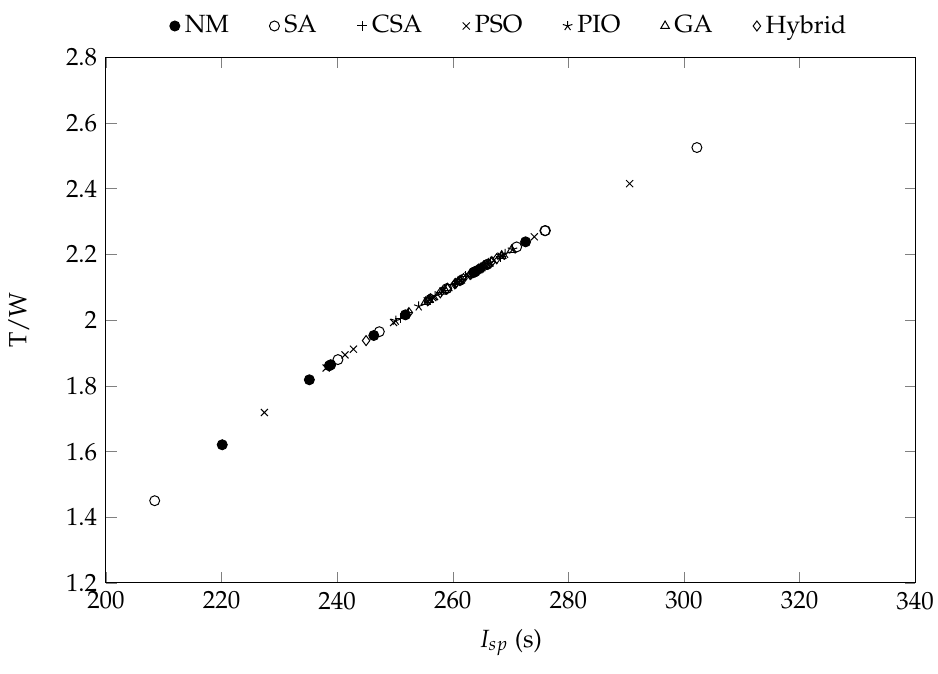
Figure 5. GG Cycle: T/W vs. I sp for all